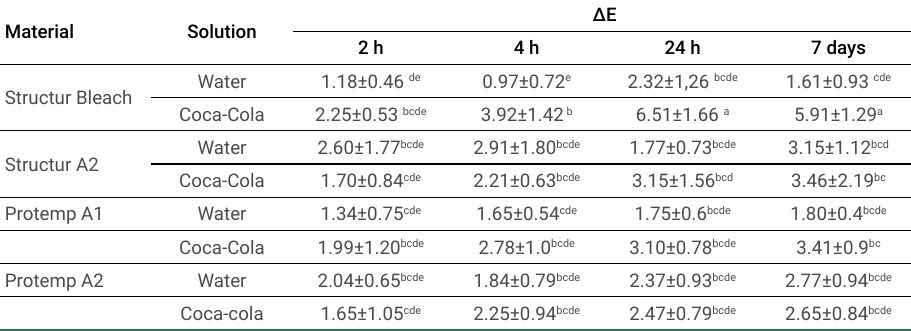
Table 2. Means and standard deviations for ∆E